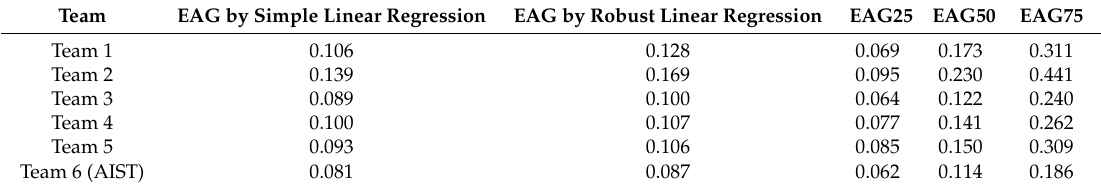
Table 3. Comparison of methods for determining the representative